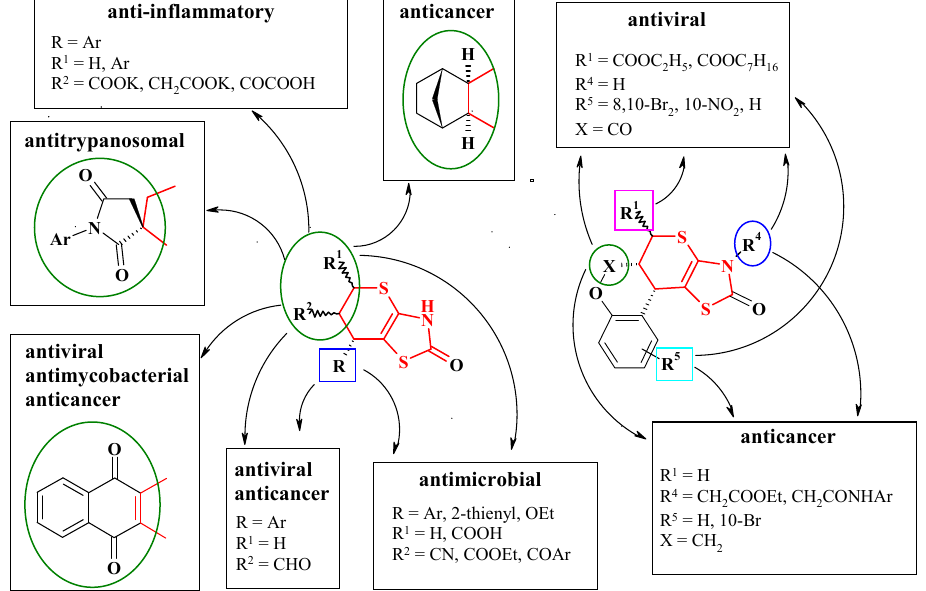
Figure 9. Some structure-activity relationships of thiopyrano[2,3- d ]thiazoles.